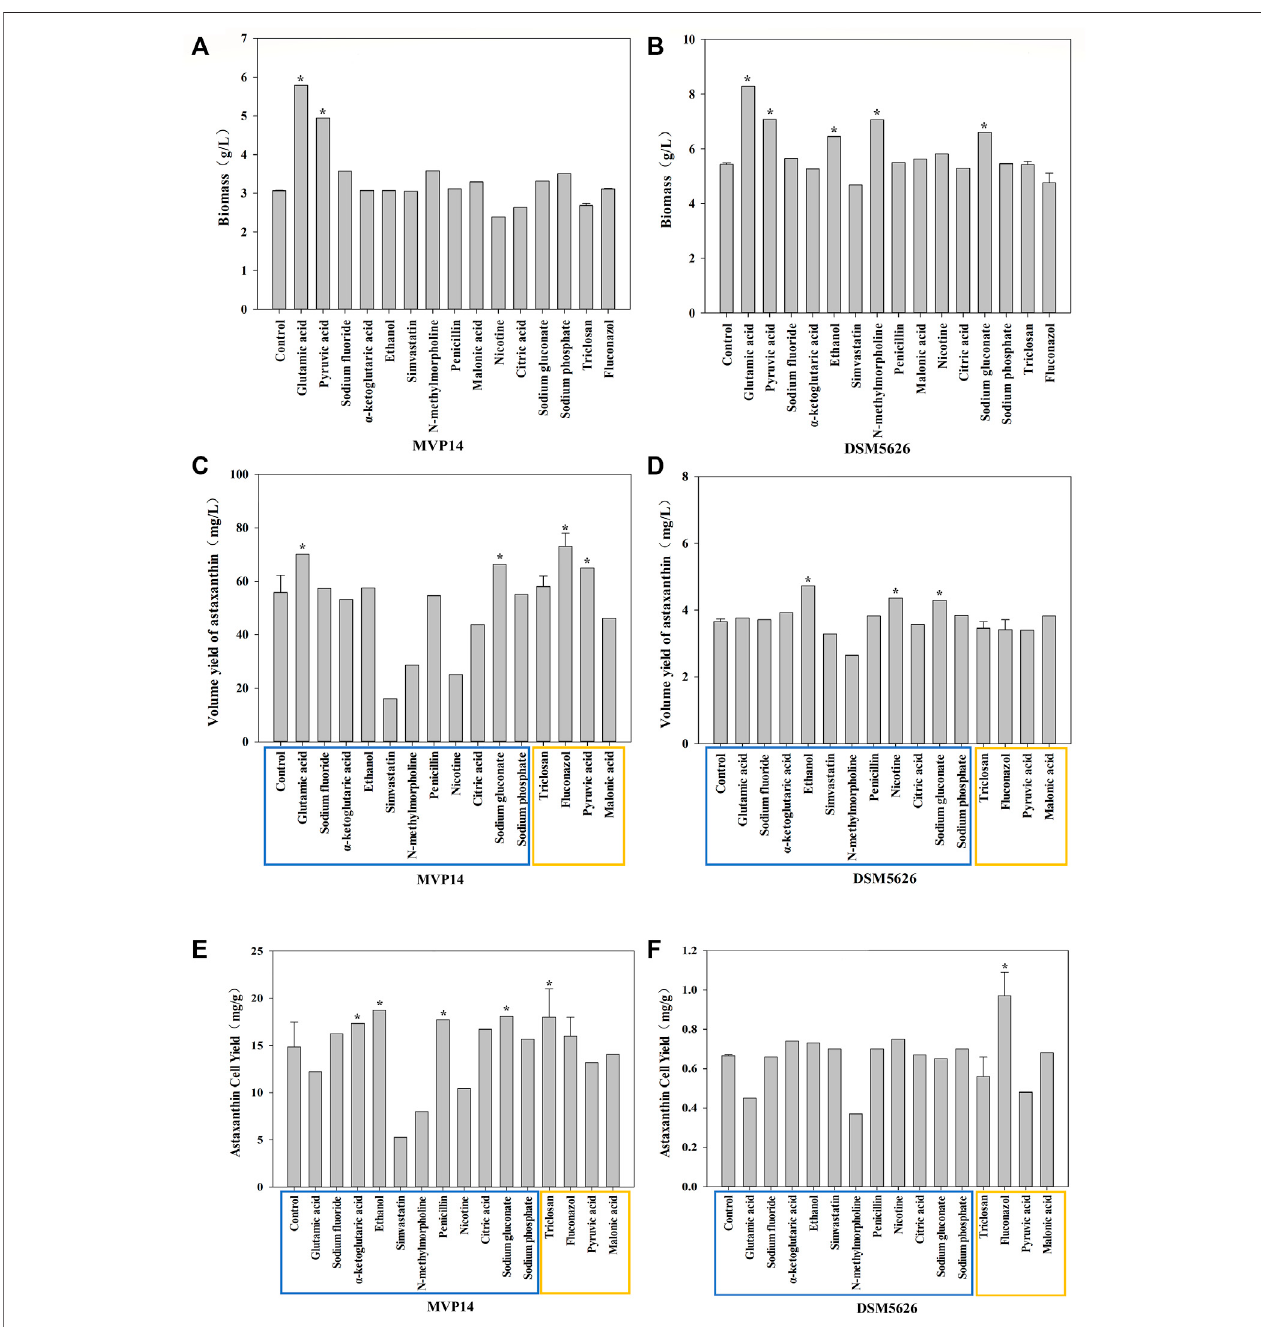
FIGURE 1 | The effect of single regulator on biomass of P. rhodozyma MVP14 (A) and DSM5626 (B) . The effect of single regulators on astaxanthin volume yield of P.rhodozyma MVP14 (C) andDSM5626 (D) .Theeffectofsingleregulatorsonastaxanthin cellyieldof P.rhodozyma MVP14 (E) andDSM5626 (F) .Theblueboxshows the additives acting on the synthetic pathway, and the yellow box shows the additives acting on the competitive pathway. (*signi fi cantlydifferent from control, p < 0.05).